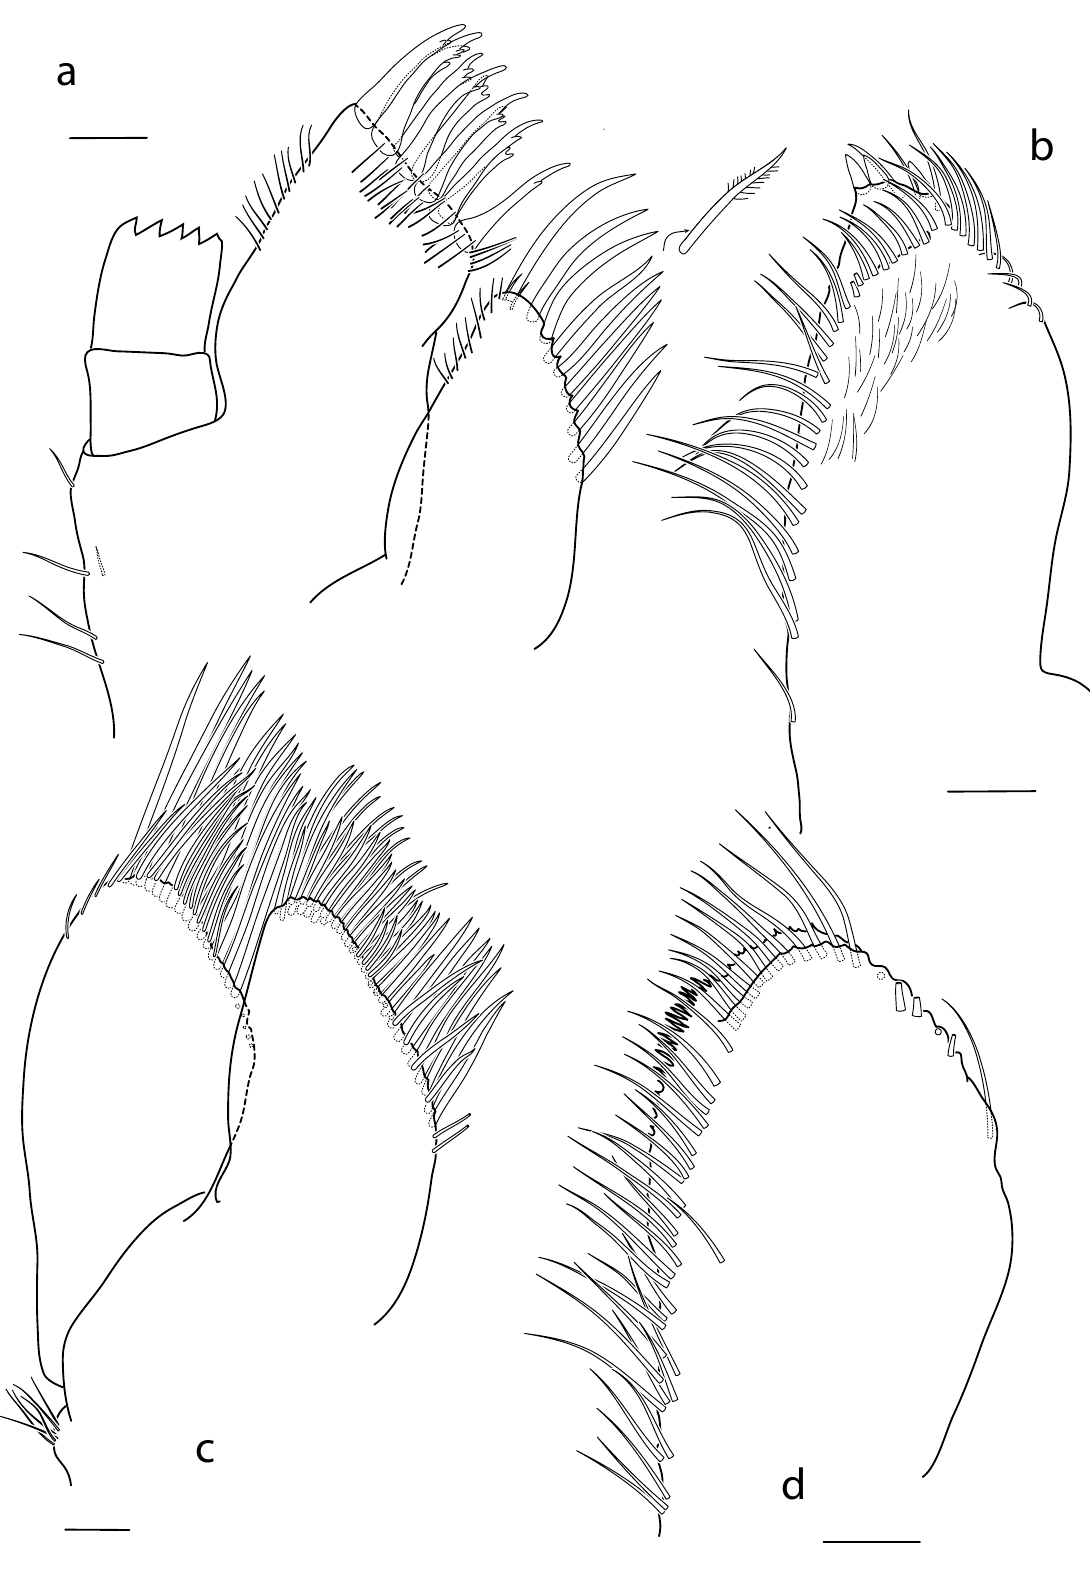
Fig. 14. Epimeria (Metepimeria) acanthurus (Schellenberg, 1931), ♀, 22 mm (ZMB 34099). a . Maxilla 1. b . Inner plate of maxilliped. c . Maxilla 2. d . Outer plate of maxilliped. Scale bars = 100